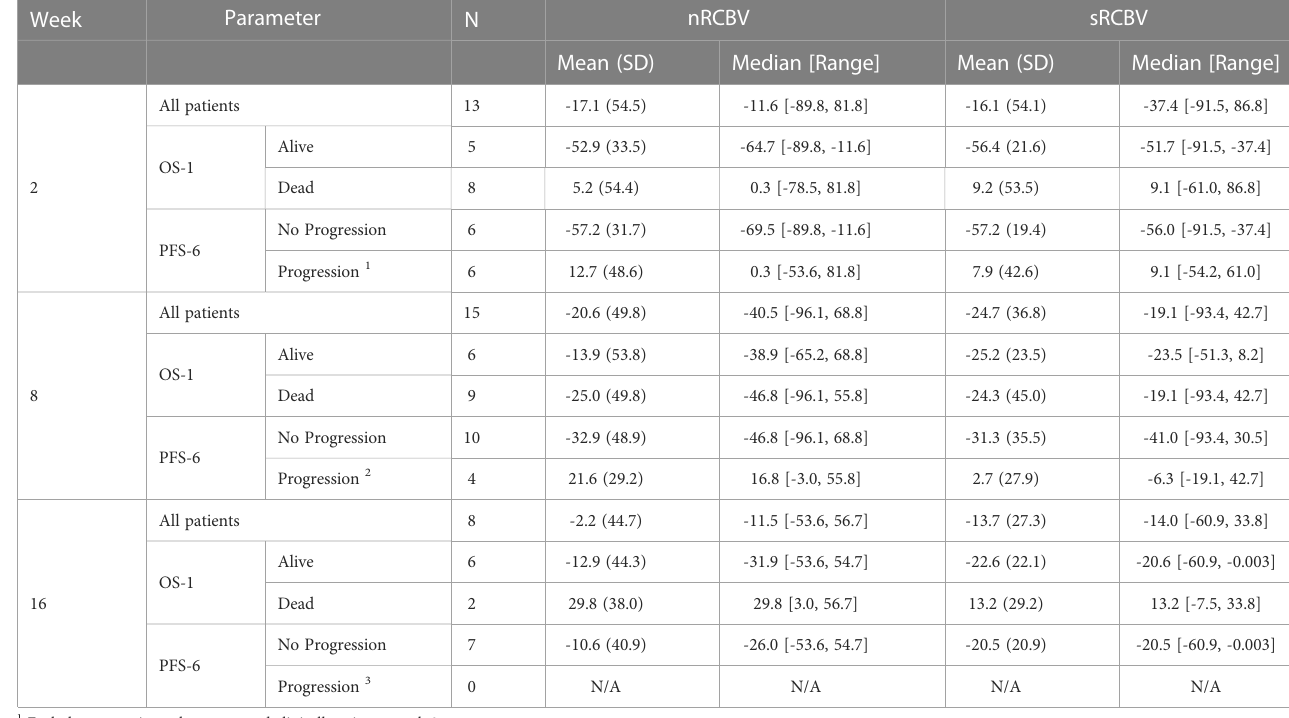
TABLE 2 Summary statistics of percent change in nRCBV and sRCBV by time point for the cohort of 2D-T1 non-progressors, overall and strati fi ed by patient outcome (OS-1 and PFS-6).